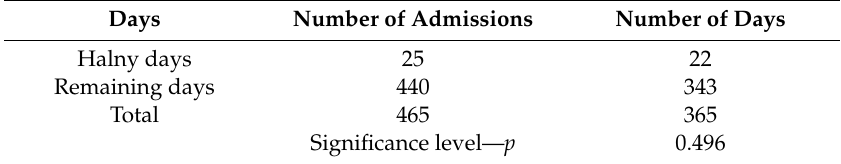
Table 4. Number of admissions on halny days and on the remaining days of the year.